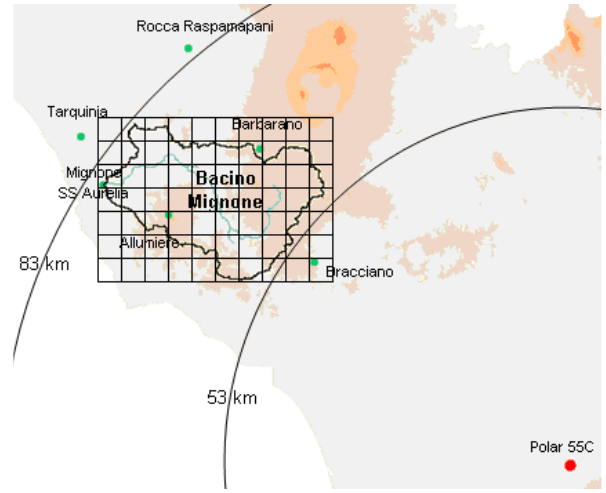
Fig. 2. Study area and radar position. The red dot in the lower right-hand corner represents the position of the Polar 55C radar. A 2km × 2km grid was overlaid over the map of entire basin, located in the Northeast with respect to the radar. The green dots represents the available rain gauge stations in the study